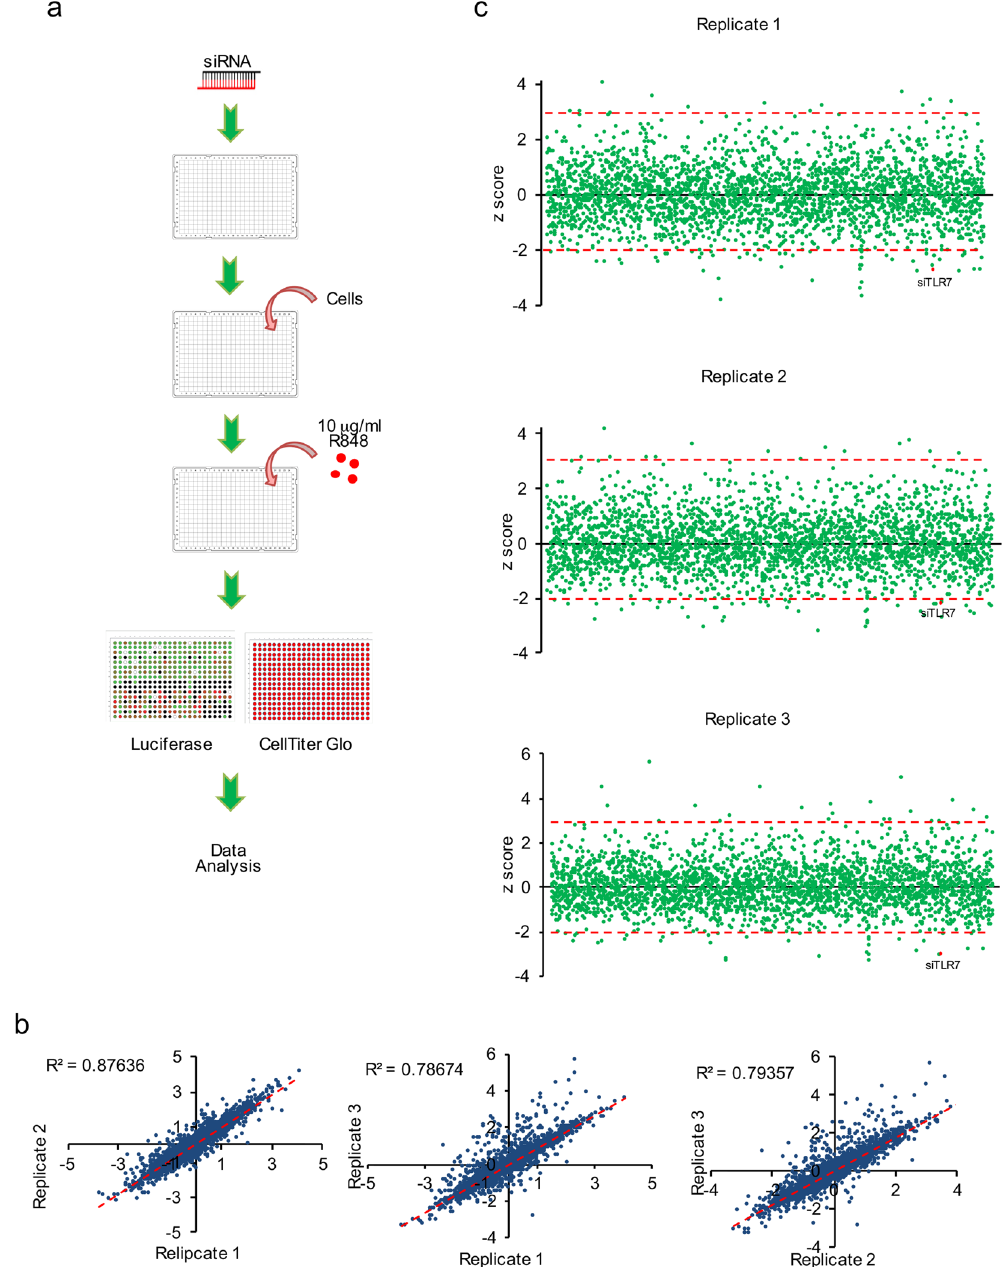
Figure 4. SMARTpool siRNA screen of IRF5 signaling pathway. (a ) Outline of the screening procedures. ( b ) Determination of the R 2 value of 3 replicates. ( c ) Summary of 3 replicates of SMARTpool RNAi screens. Z scores of 3 and -2 (P < 0.05) are indicated by red dash lines. The positive control siTLR7 is